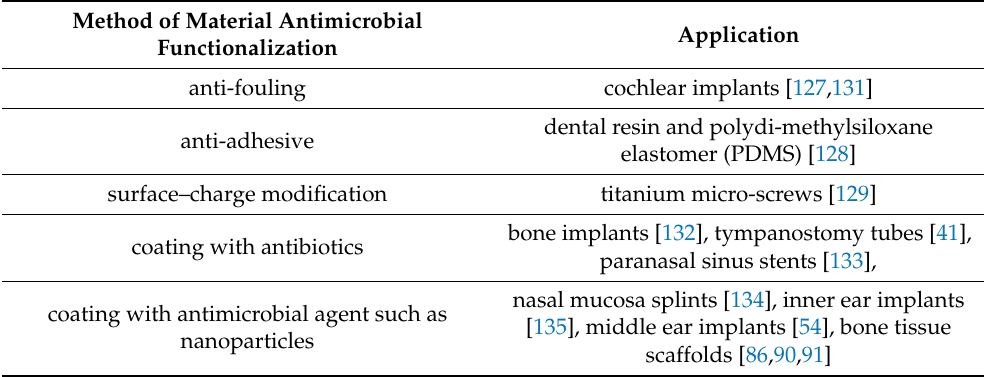
Table 2. Various methods to synthetize materials with antimicrobial properties and their uses. Method of Material